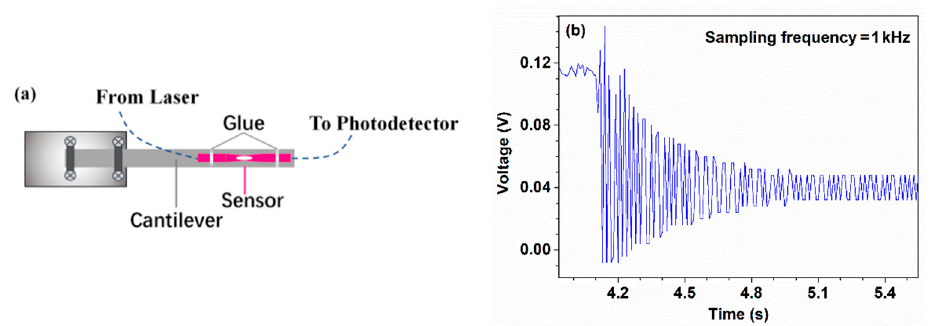
Figure 9. ( a ) Schematic of the experimental setup for damped vibration testing. ( b ) A typical time-domain spectrum of the output voltage when the HBF was exposed to damped vibration.